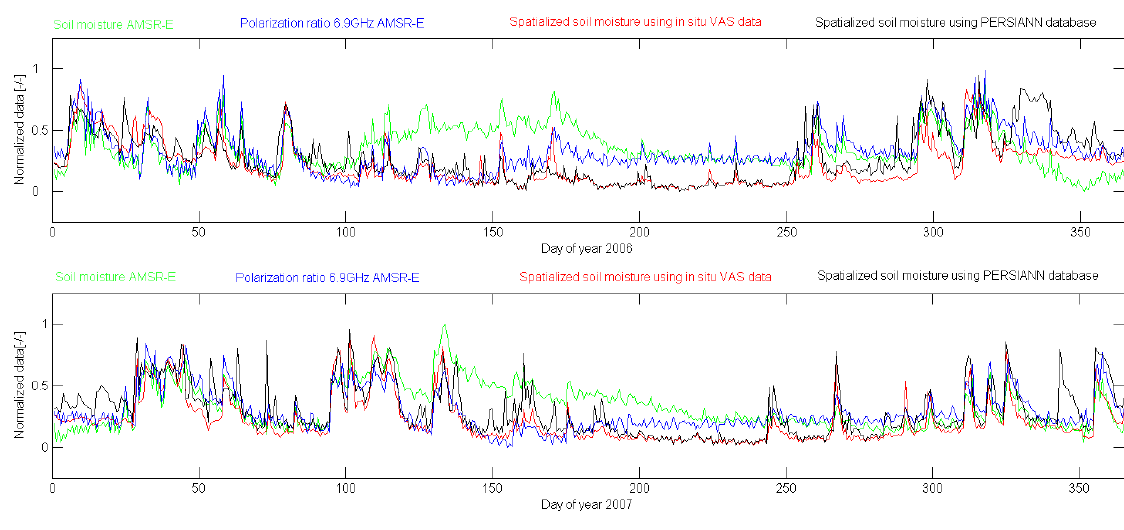
Fig. 9. Comparison between spatialized soil moisture using in situ rain gauge observations(red line) and PERSIANN datadase (black line), AMSR-E soil moisture product (green line) and AMSR-E polarization ratio at 6.9GHz (blue line) for 2006 (upper figure) and 2007 (bottom figure). The data are normalized between [0, 1].